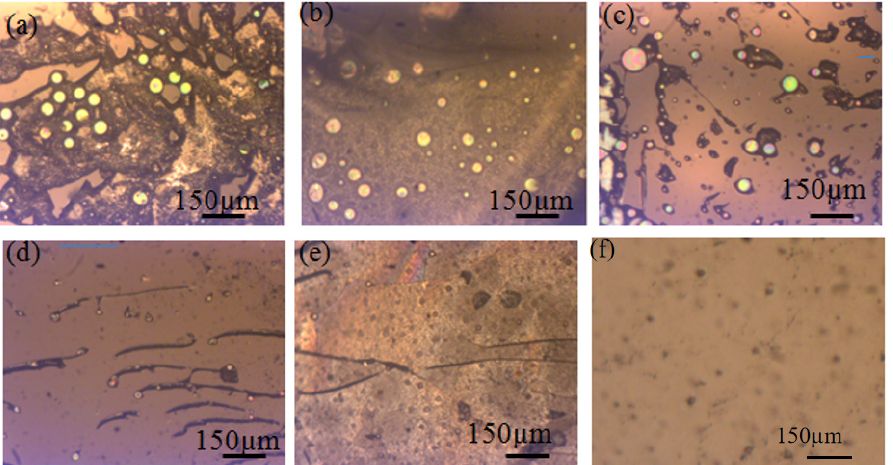
Figure 3. The voids in the fractured interface after the pull test: ( a , b ) Annealing in air and under vacuum at 400 °C for 60 min, respectively; ( c ) Annealing in air at 450 °C for 30 min and annealing under vacuum at 450 °C for 30 min; ( d , e ) Annealing in air at 450 °C for 30 min and annealing under vacuum at 450 °C for 30 min and annealing in air at 450 °C for 30 min and for 60 min, respectively; ( f ) Annealing in air at 450 °C for 30 min and annealing under vacuum at 450 °C for 30 min and annealing in air at 500 °C for 60 min.